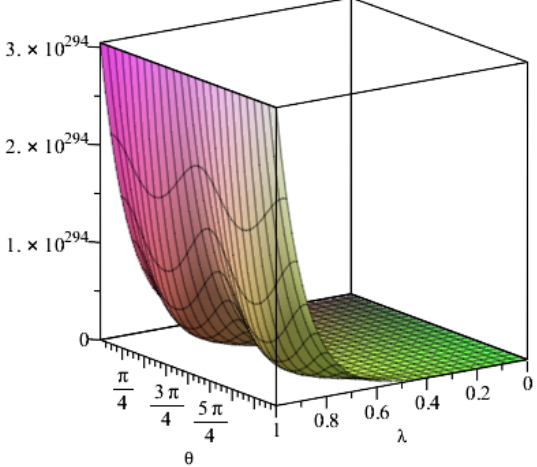
Figure 11. Relationship between vertical stress and resistance.